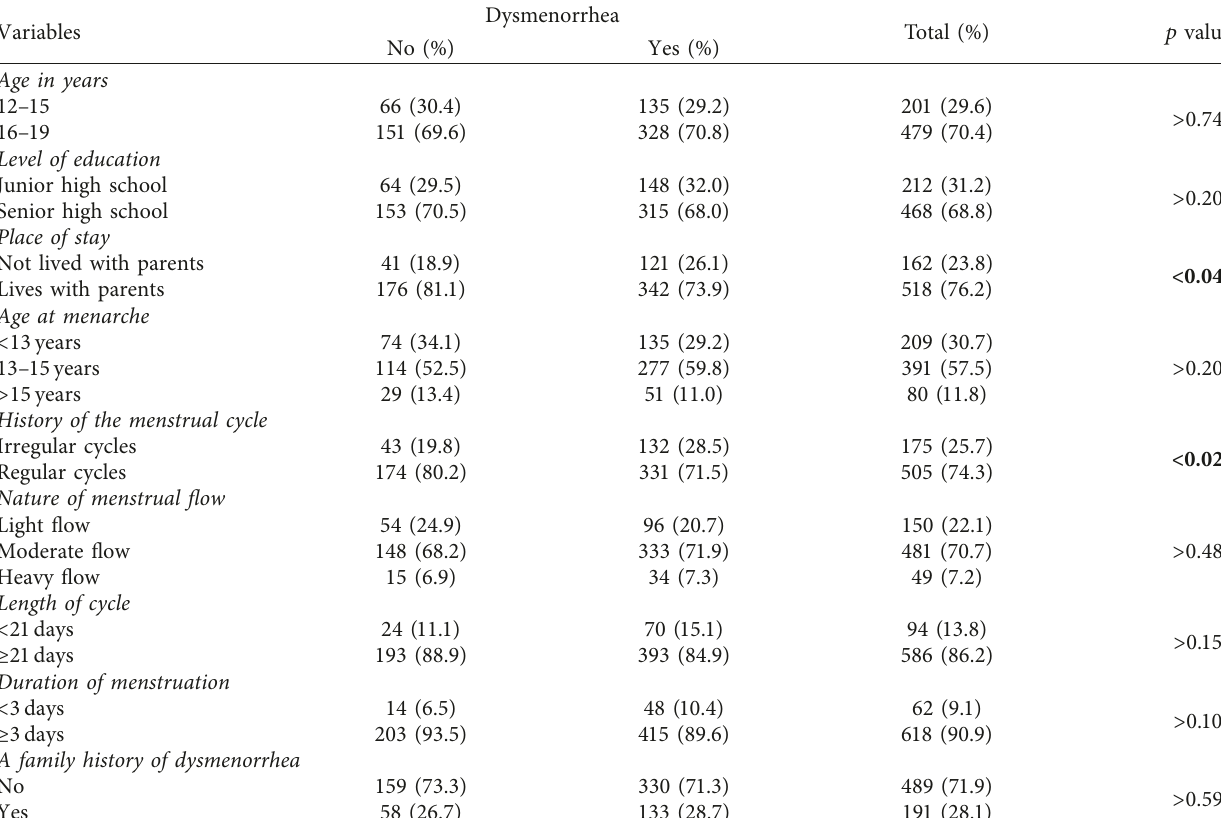
Table 1: Univariate analysis for the experience of dysmenorrhea among the study participants.